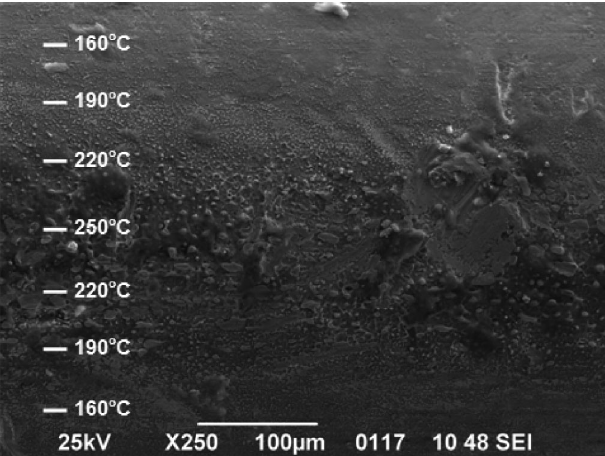
FIG. 8. Photograph (electron microscope) of the central part of the waistband after irradiation by 4 : 8 (cid:2) 10 4 pulses (magnifica- tion of 250).